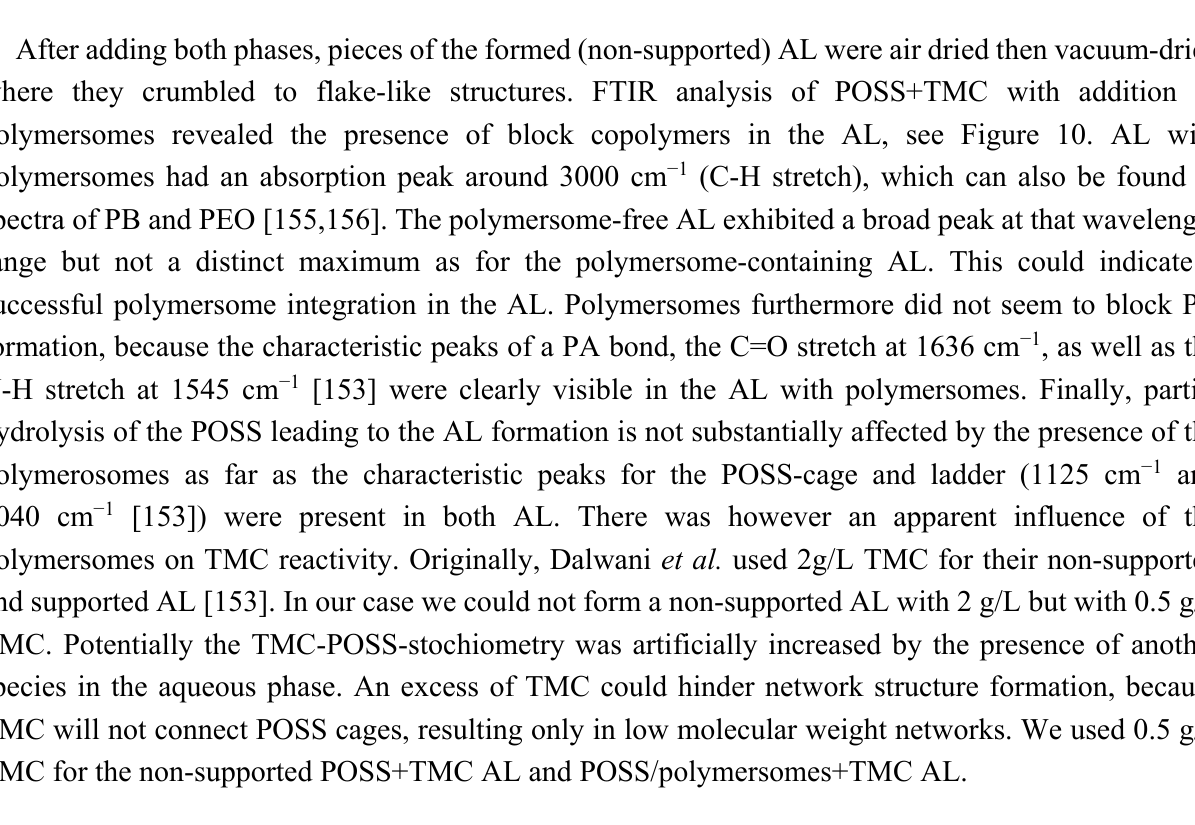
Figure 9. Chemical structure of POSS and TMC and the resulting AL. POSS as the amine linker generate a highly stable and well-defined AL with